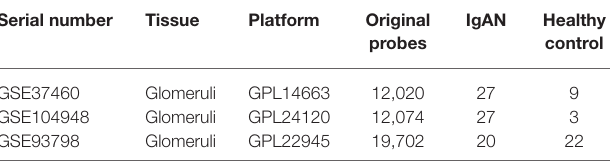
TABLE 1 | Datasets used in this study *